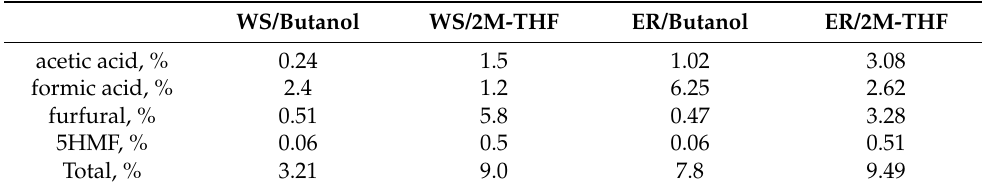
Table 6. Inhibitors produced at the optimized pretreatment conditions (as 100 × weight of in- hibitors/weight of loaded dry